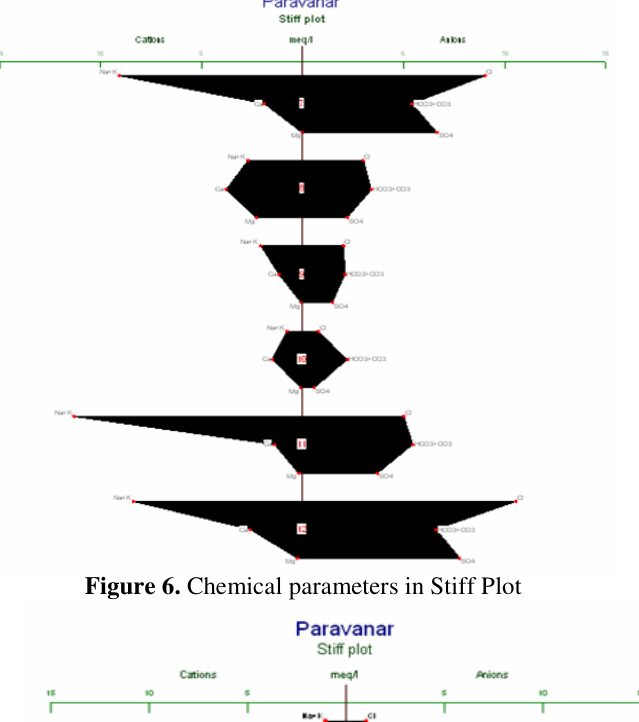
Figure 6. Chemical parameters in Stiff Plot